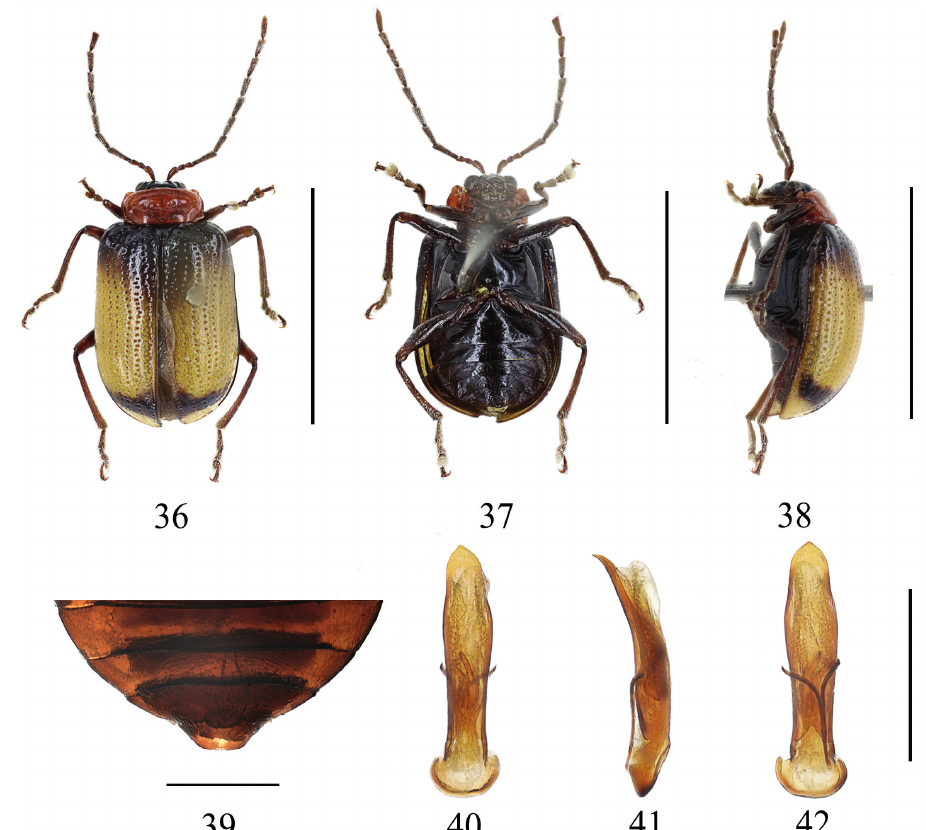
Figures 36–42. Gallerucida rufipectoralis sp. nov. 36 dorsal view (holotype) 37 ventral view (holotype) 38 lateral view (holotype) 39 ventral view of 5 th ventrite, male (paratype) 40 aedeagus, dorsal view (paratype) 41 ditto, lateral view (paratype) 42 ditto, ventral view (paratype). Scale bars: 5 mm ( 36–38 ); 1 mm ( 39–42 Diagnosis. Gallerucida rufipectoralis closely resembles G. sauteri Chûjô, but the former has dark brown femora, black head and ventral surface, subequal 3 rd and 2 nd segments of the antennae, and punctured pronotum depression.